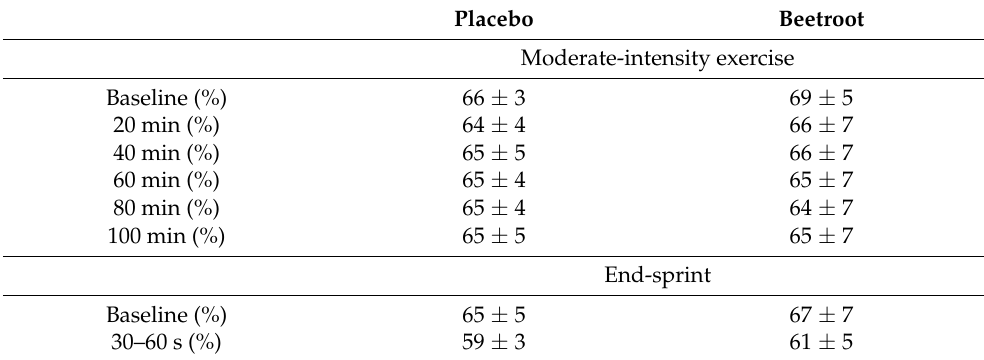
* Data are presented as group mean ± SD. Placebo, nitrate-depleted beetroot powder; beetroot, ni- trate-rich beetroot powder.